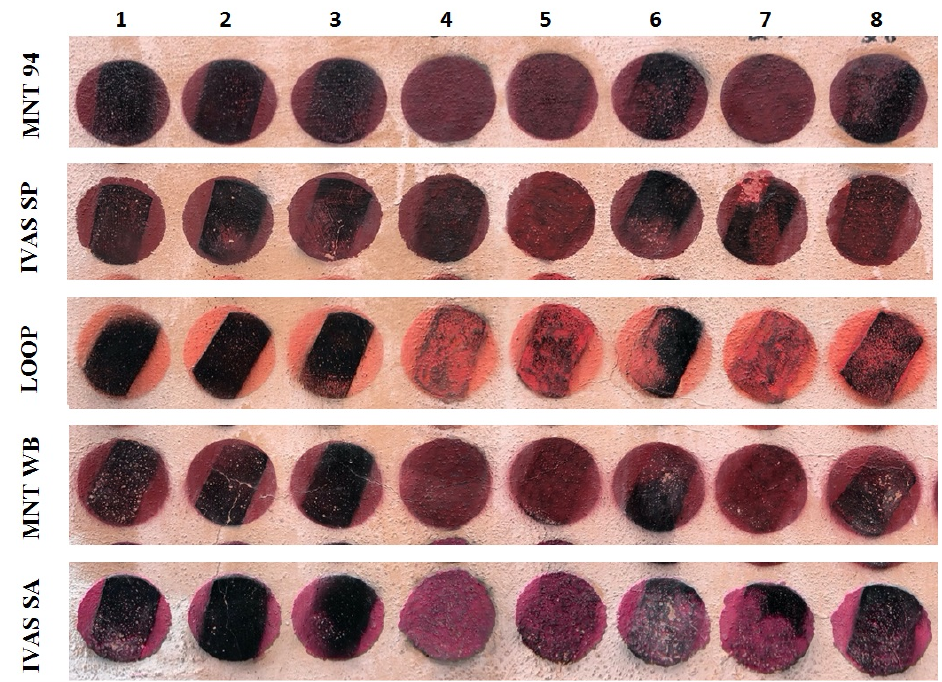
Figure 8. Cleaning tests performed on vandalized